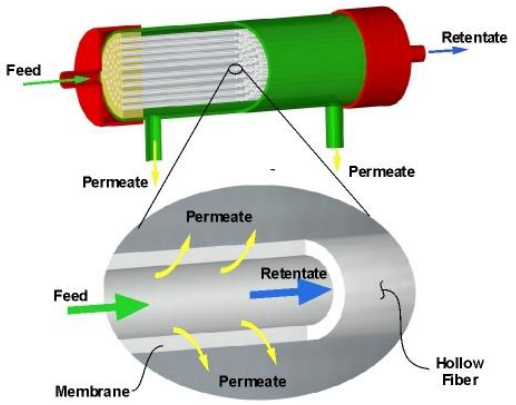
Figure 5. Membrane gas separation principle (Permselect, available online [37]).